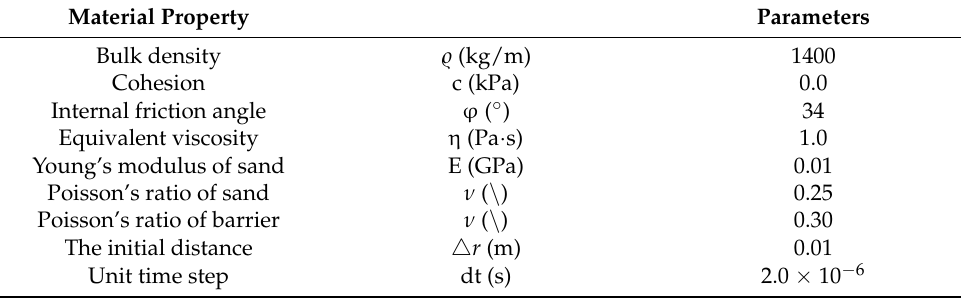
Table 1. Key input parameters of